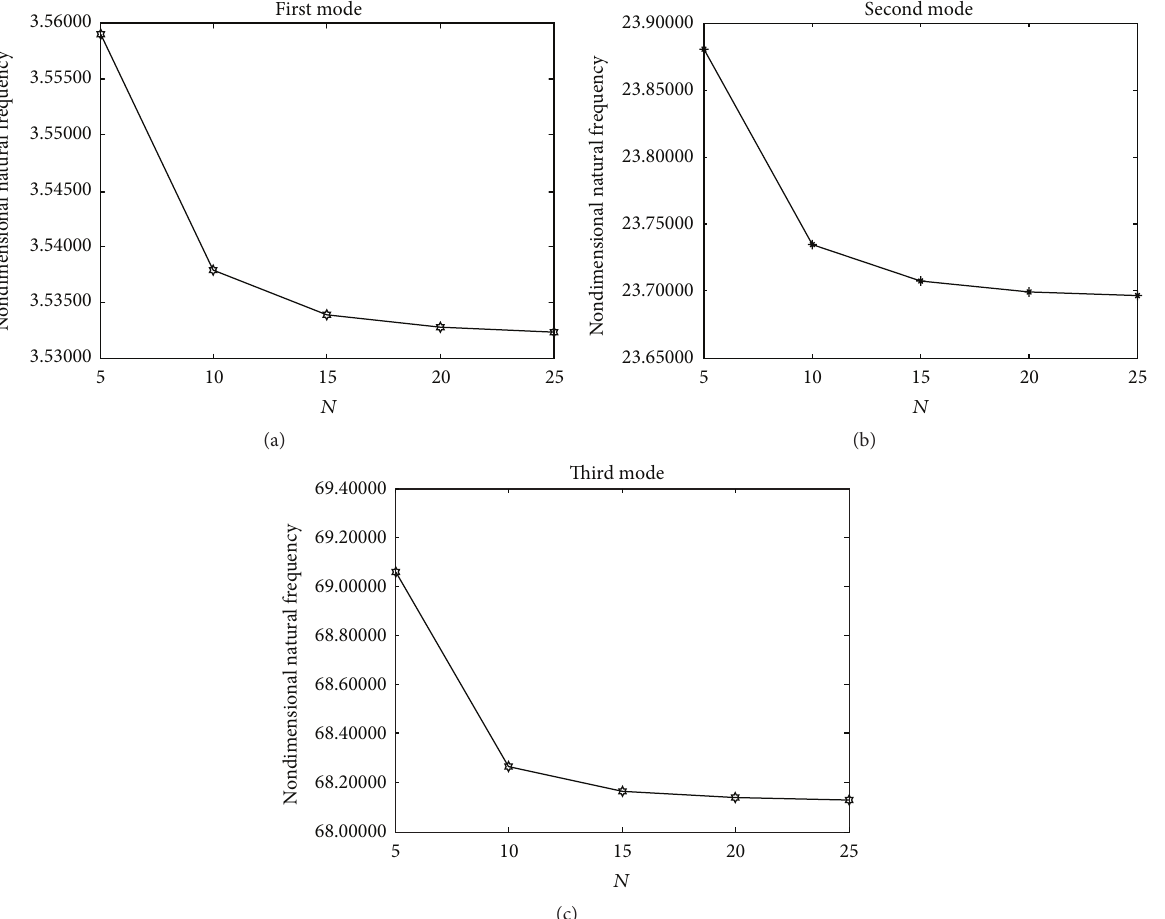
Figure 11: Convergence of natural frequencies for axially exponentially FG cantilever beams with respect to spline node number N (𝛼 = −10) .